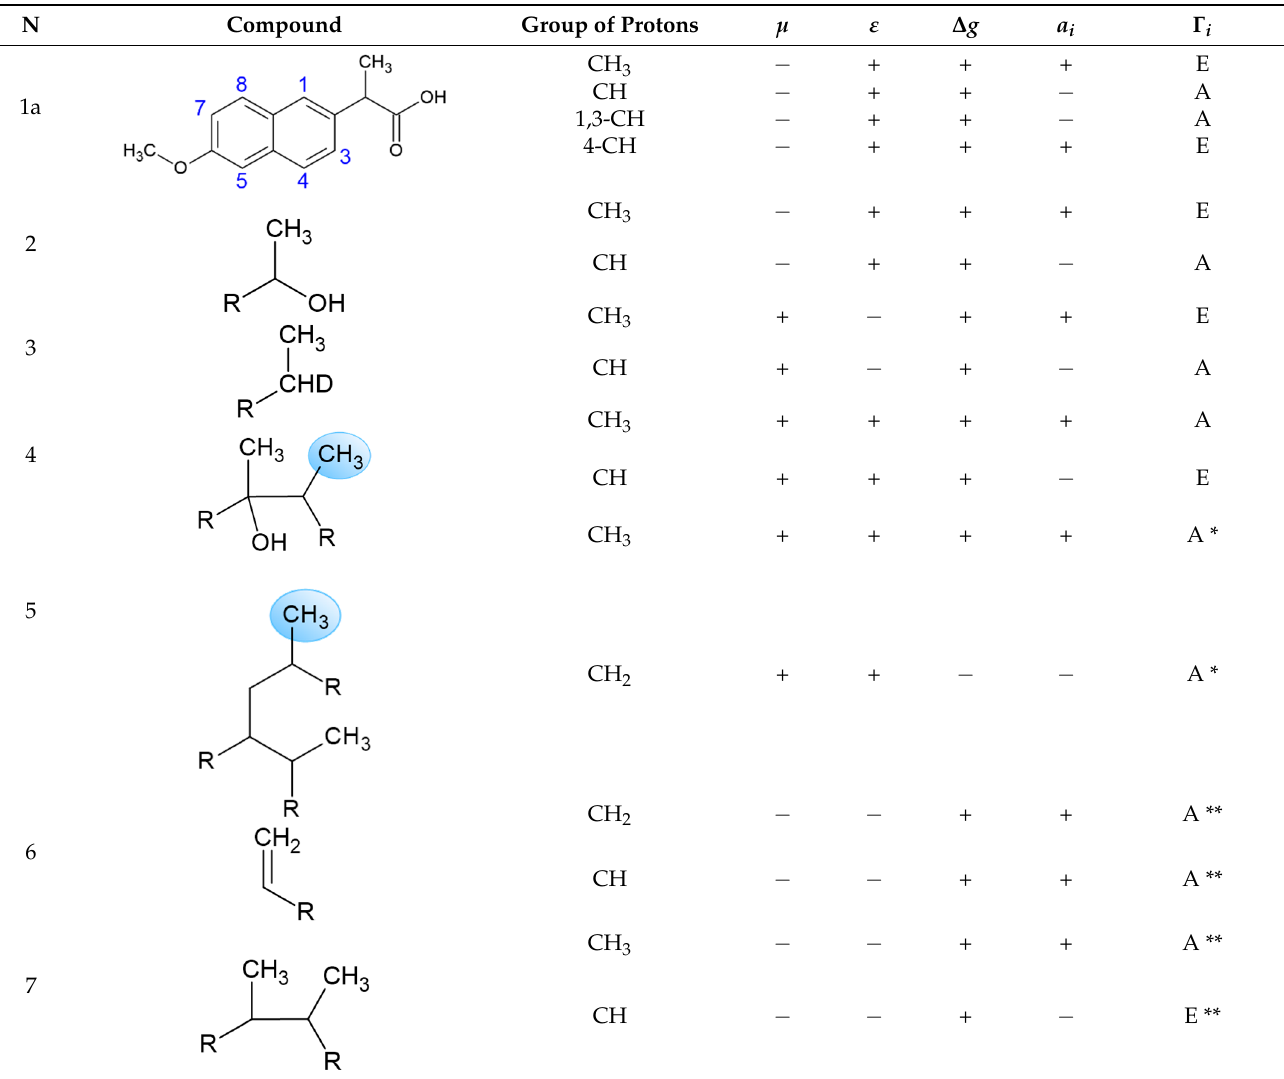
Figure 2. ( a ) 1 H NMR and TR ‐ CIDNP spectra of 4.3 mM NPX; ( b ) an equimolar mixture of NPX and GL (4.3 mM) in acetonitrile:water (1:2) solution; in insert: pseudo ‐ steady ‐ state (PSS) CIDNP spectra of NPX with GL under the same conditions (green). The delay time between the laser pulse and the NMR detection pulse is 0. Numbers designate the aromatic protons of NPX (blue) and GL (red). The analysis carried out according to Kaptein’s rules is presented in Table 1. Table 1. Analysis of CIDNP signs of NPX products.